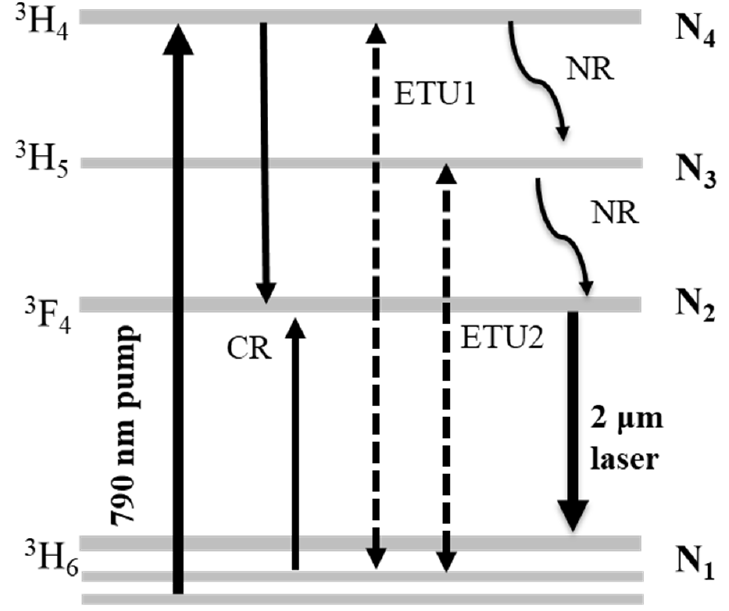
Figure 5. Energy-level transition diagram of Tm 3+ ion.